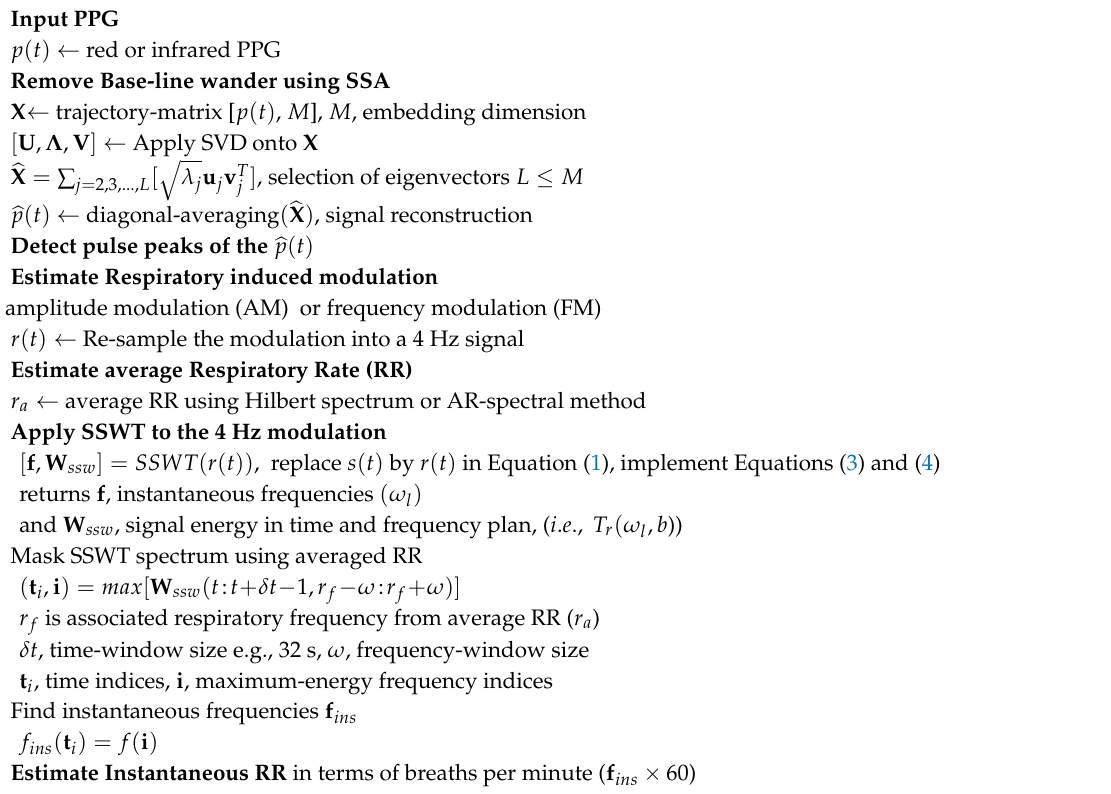
Algorithm 1 Estimation of Instantaneous RR from PPG